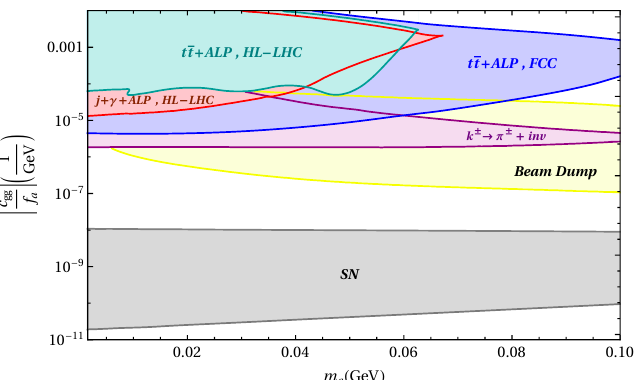
Figure 2. The expected excluded regions of the ALP model parameter space ( | c gg / f a | , m a ) at 95% CL obtained from t ¯ t + ALP and j + γ + ALP channels are presented. The regions derived from t ¯ t + ALP and j + γ + ALP processes at HL-LHC are corresponding to an integrated luminosity of 3 ab − 1 and are adapted from Ref. [20]. The blue region shows the constraint obtained in the present analysis using t ¯ t + ALP process at FCC-hh at a center-of-mass energy of 100 TeV with an integrated luminosity of 30 ab − 1 . The grey region denoted by SN presents the bound from supernova neutrino burst duration adapted from Ref. [7]. The region labeled by K ± → π ± + inv adapted from [8] (purple) and beam dump (yellow) present the constraints from Kaon decay and from the proton beam dump experiment CHARM adapted from Ref.